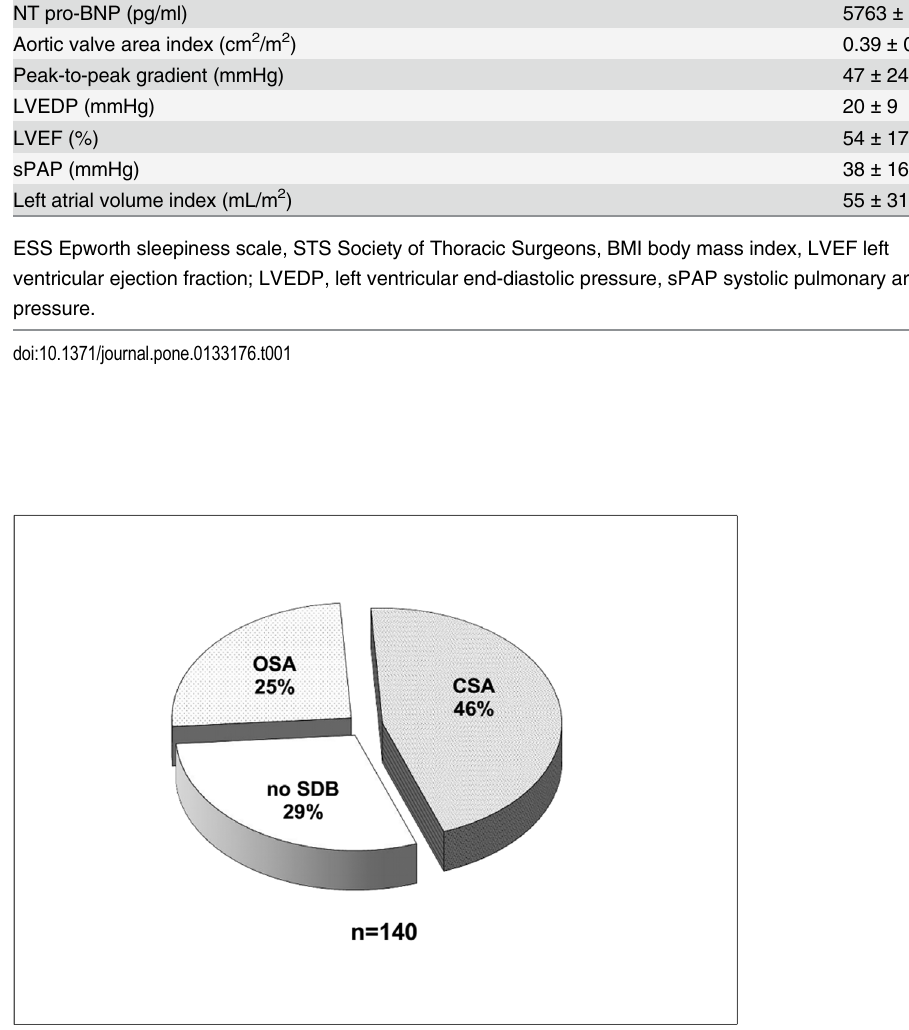
Fig 1. Prevalence and type of sleep disordered breathing (SDB) in 140 patients with severe aortic